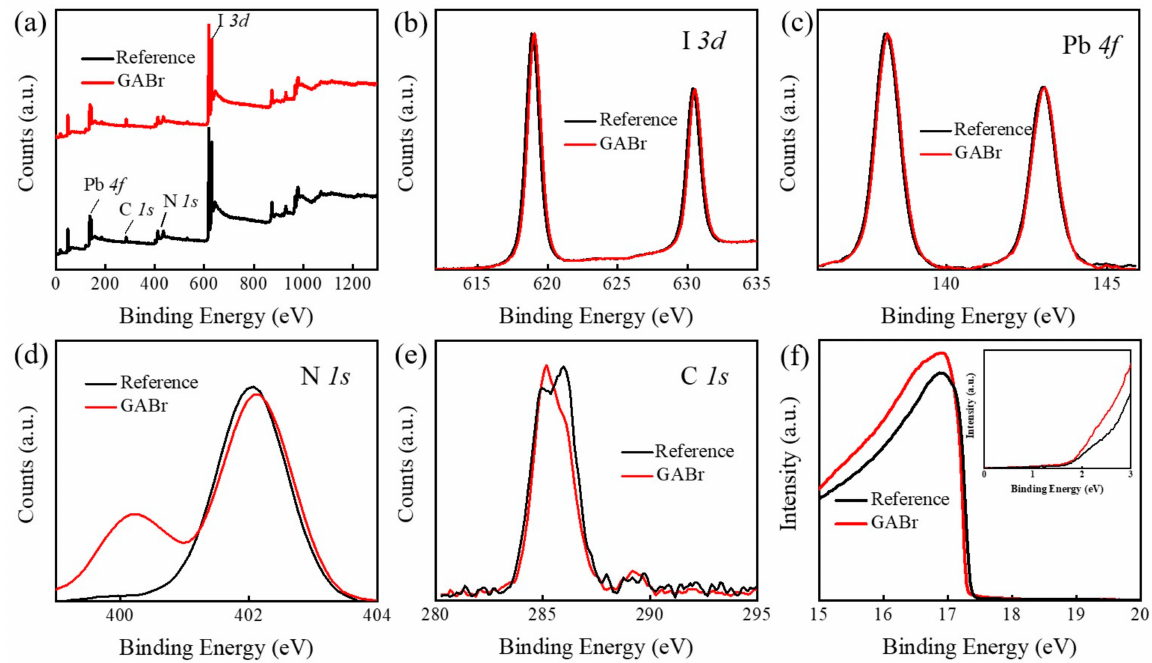
Figure 5. ( a ) The elemental survey spectra of MAPbI 3 and GABr-treated MAPbI 3 . High-resolution XPS spectra of ( b ) I 3d, ( c ) Pb 4f, ( d ) N 1s, ( e ) C 1s of MAPbI 3 and GABr-treated MAPbI 3 . ( f ) The UPS secondary electron edge cut-offs of these two samples, and the inner image is the corresponding magnified details of the valence band